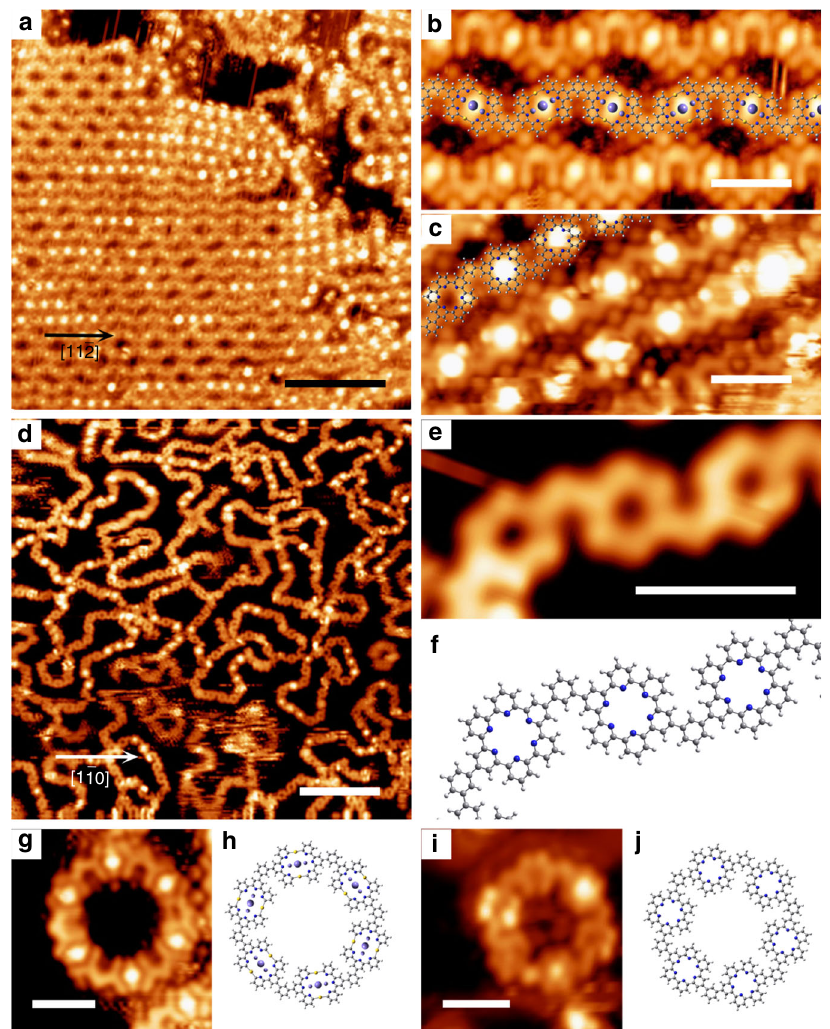
Fig. 7 Fe-tpy templated debrominated C – C coupling of m - DBTB . a An STM overview with the sample annealed at 457 K. b High-resolution STM of the organometallic chains with structural models overlaid. The Fe-coordination is represented by purple spheres, while the central sphere is bold to highlight the speci fi c state of the central Fe atom. c High-resolution image of SPy units (III-mode). d STM overview of the SPy- m -Ph ribbons after annealing at 547 K. e , f Segments of the ribbon and the structural model. g – j The C-Au-C organometallic and C-C coupled hyper-ring units with their corresponding structural models. Scale bars: ( a , d ) 10 nm; ( b , c , e , g and i ) 2 nm. Data acquisition conditions ( T = 293 K): ( a ) − 1.0 V, 0.5 nA; ( b ) − 0.5 V, 2.0 nA; ( c ) − 1.2 V, 0.5